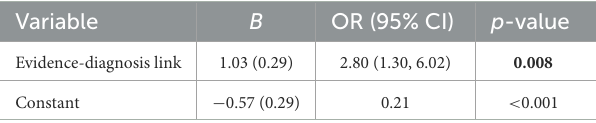
TABLE 2 Results of a backward, stepwise, multivariable analysis for predictors of nutrition diagnosis resolution in patients with Type 1 and Type 2 diabetes mellitus ( n =